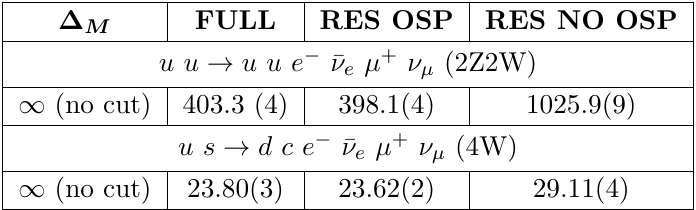
Table 2 . Cross sections in attobarns ( ab ) for some VBS processes, for All diagrams are taken into account for the full calculation (FULL), while only double resonant diagrams contribute to the two rightmost columns, with (RES OSP) and without (RES NO OSP) projection. Selection cuts are: p j 300 GeV.